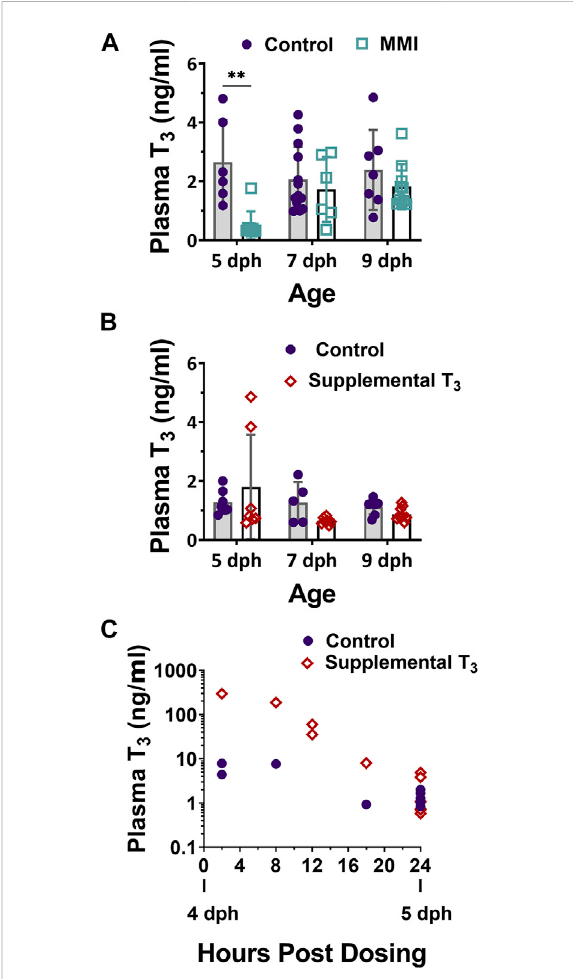
FIGURE 1 Plasma 3,3 ′ , 5- Triiodo-L- thyronine (T 3 ) levels in 5, 7, and 9 dph red-winged blackbird nestlings after (A) Methimazole (MMI) or (B) T 3 treatmenton2,3,and5dph. (A) AftertreatmentwithMMI, plasma T 3 levels were lower than controls but recovered